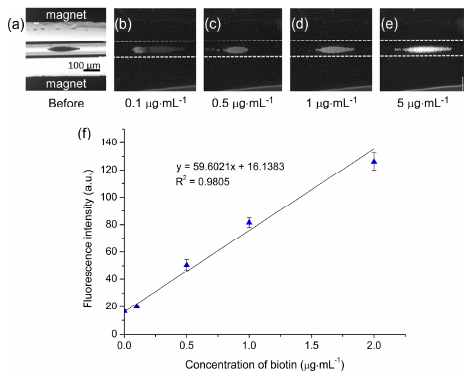
Figure 6. Streptavidin-biotin assays performed by flushing a solution of fluorescently labelled biotin over a trapped plug of streptavidin functionalised magnetic particles. ( a ) Bright-field image of the trapped particle plug. ( b – e ) Fluorescence images of streptavidin particle plugs exposed to varying concentrations of biotin: ( b ) 0.1 µg·mL − 1 ; ( c ) 0.5 µg·mL − 1 ; ( d ) 1 µg·mL − 1 ; and ( e ) 5 µg·mL − 1 . ( f ) Calibration graph of particle plug fluorescence intensities exposed to a range of fluorescently labelled biotin concentrations.